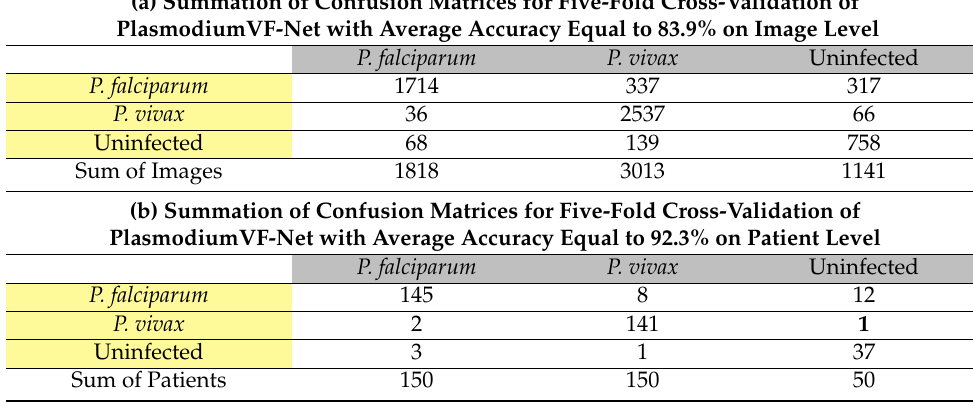
Figure 7. This figure compares the response of PlasmodiumVF-Net for the P. falciparum , P. vivax , and uninfected patient datasets. ( A ) Subfigure A shows a histogram of parasite detection on image level for P. falciparum , ( B ) Subfigure B shows a histogram of parasite detection on image level for P. vivax , and ( C ) Subfigure C shows a histogram of both P. falciparum and P. vivax parasite detection on image level for uninfected patients. From the histograms of Subfigure A and B, it is noticeable that our framework is responding well and identifies the existing parasites in the infected patients, while in Subfigure C, PlasmodiumVF-Net detects only a small number of false-positive parasites for uninfected patients, which shows the effectiveness of our proposed pipeline. Table 6. Confusion matrices for image-level and patient-level three-class classification for PlasmodiumVF-Net. Each matrix is the summation of five-fold cross-validation on patient level. Gray represents actual values, whereas yellow represents predicted values. The accuracy is reported in bold in the caption of each